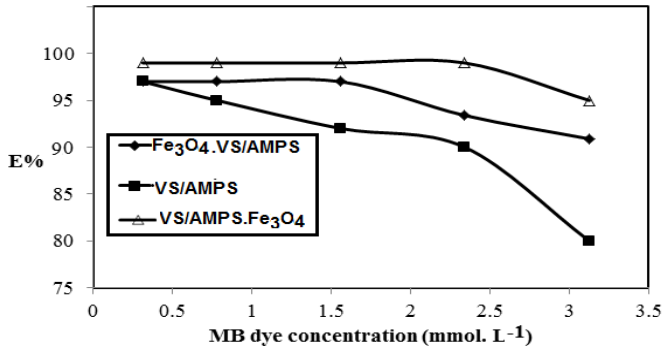
Figure 10. Effect of the MB concentrations in their aqueous solution on the removal efficiencies of Na-VS/Na-AMPS cryogels at optimum conditions.